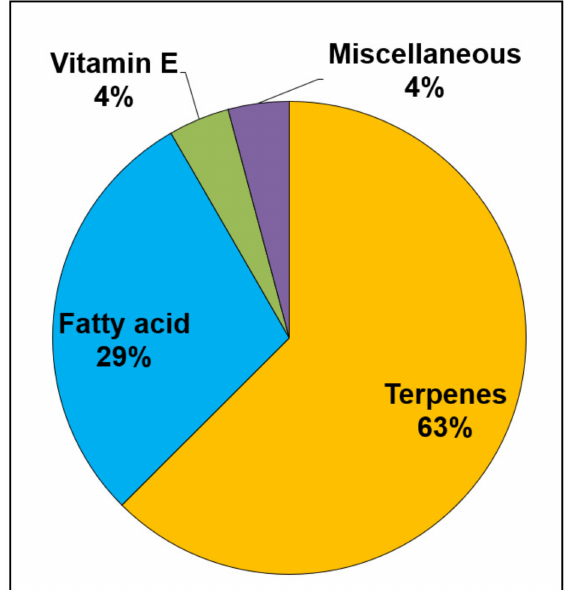
Figure 2. The types and the percentages of essential and carrier oils used in topical and transdermal pharmaceutical dosage